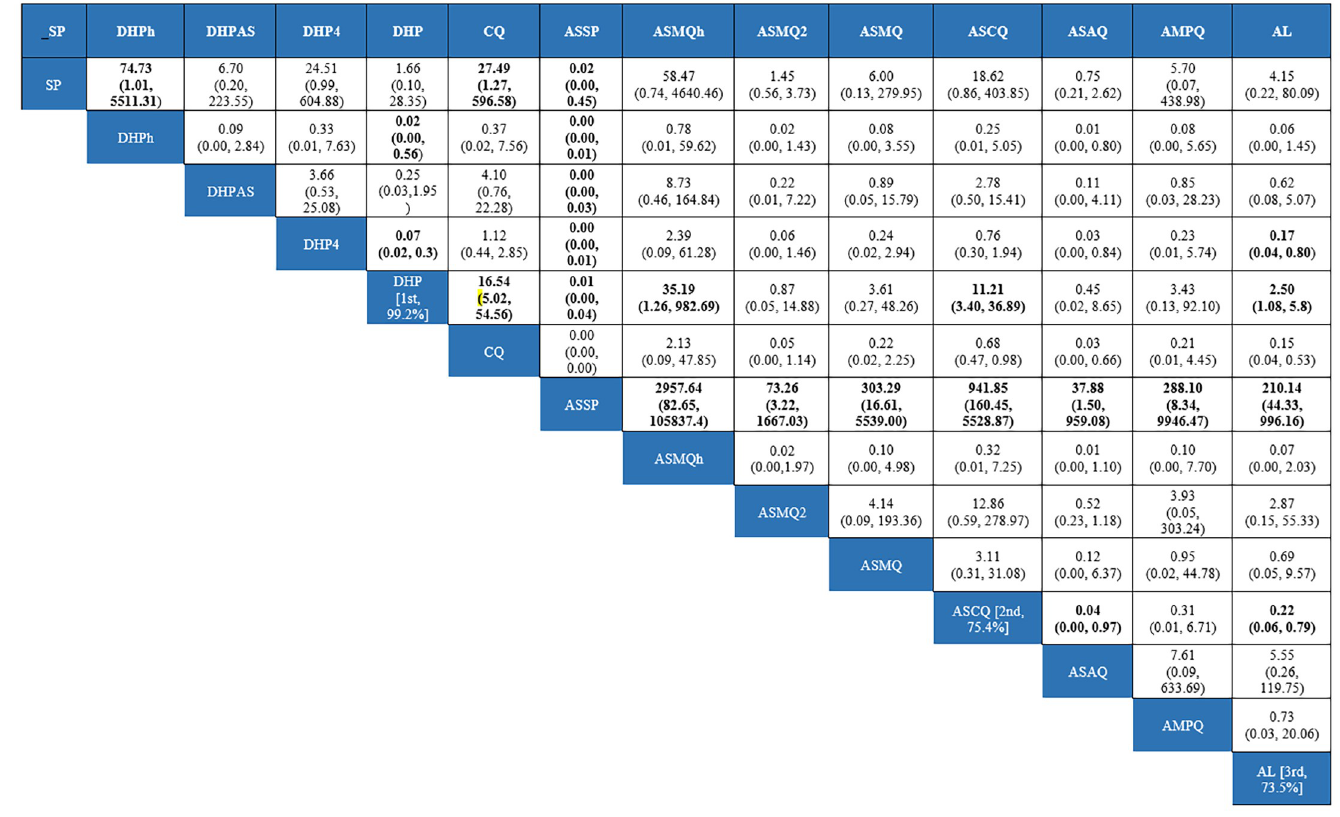
Fig 4. Network meta-analysis of antimalarial